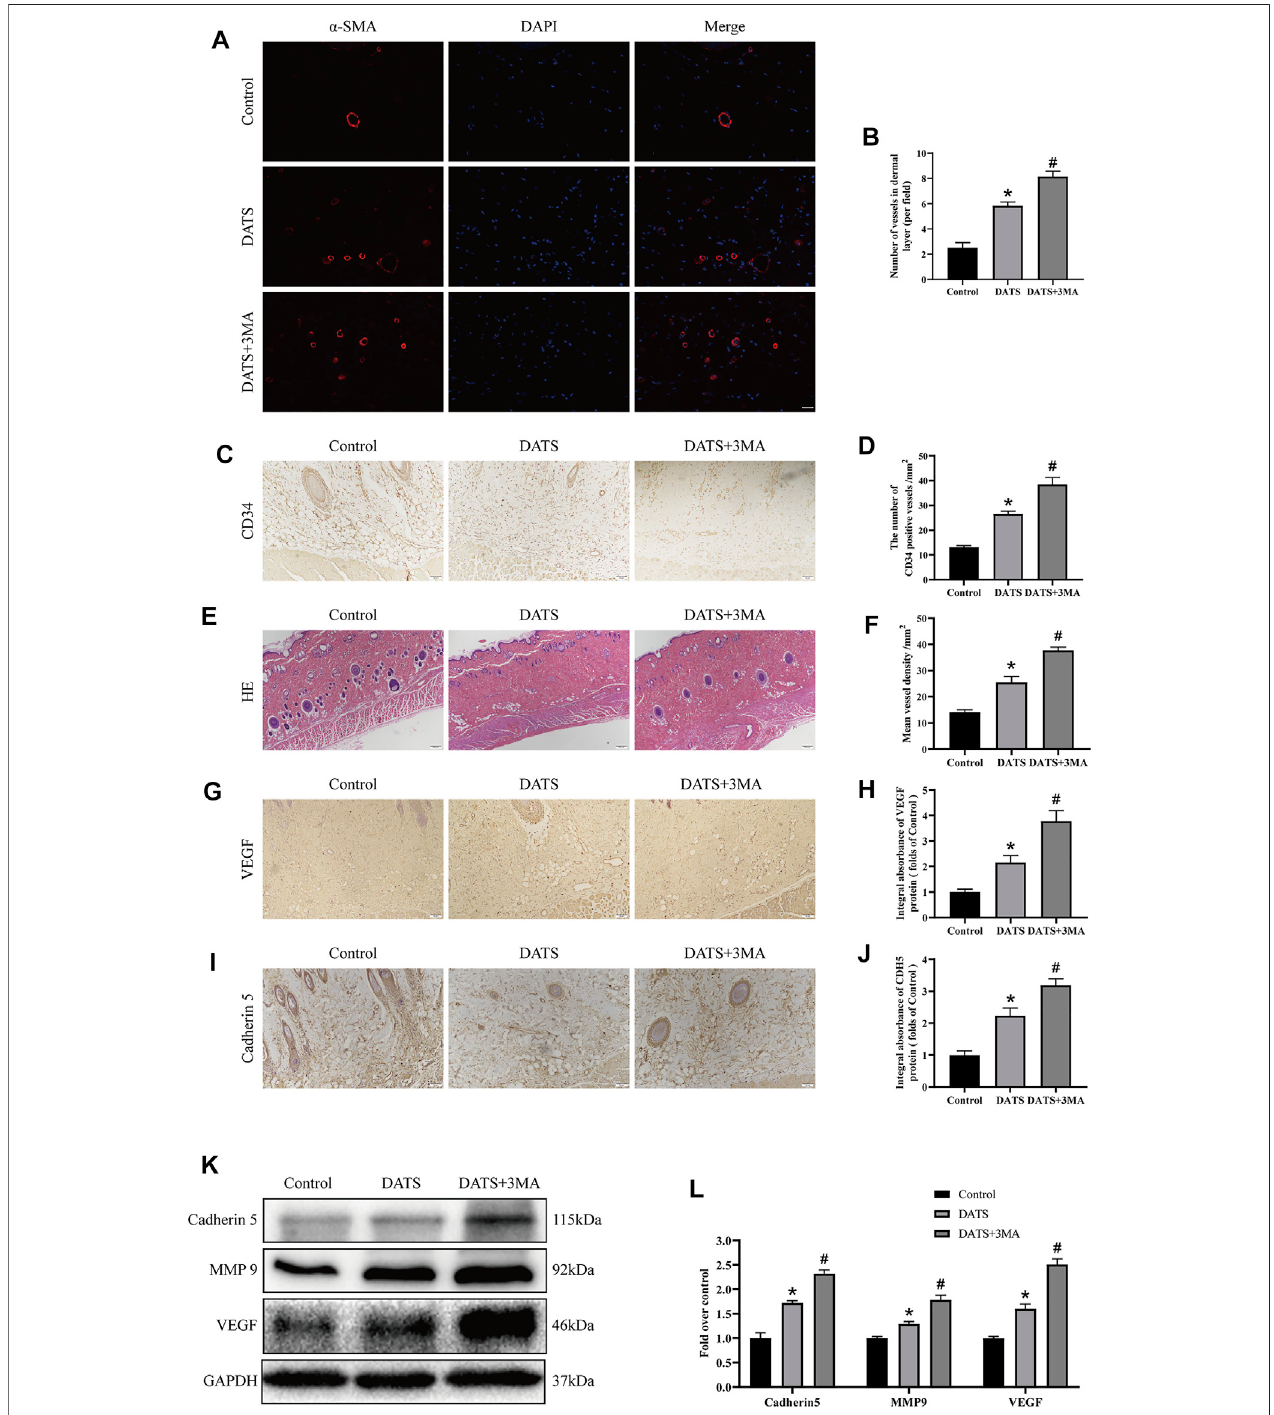
FIGURE 4 | DATS-induced autophagy affects angiogenesis in the multiterritory perforator fl ap. (A) α -SMA-positive microvessels in each group were evaluated by immuno fl uorescence(scalebar:50 µm). (B) Statisticalchartofthenumberof α -SMAmarkedmicrovesselsineachgroup. (C) IHCforCD34-positivemicrovesselsineach group (original magni fi cation ×200; scale bar, 50 µm). (D) The statistical chart describes the CD34-positive vessel density. (E) The H&E stainingshows themicrovessels and subcutaneous histology in each group (original magni fi cation ×100; scale bar, 100 μ m). (F) The statistical chart describes the percentage of microvascular density (MVD). (G,I) IHC forCadherin5and VEGFinthemultiterritoryperforator fl apineach group(original magni fi cation ×200; scalebar, 50 µm). (H, J) Statistical chart of the Cadherin 5and VEGF expression levels estimated byIHC. (K) Western blotting ofangiogenesis markers, Cadherin 5, VEGF, and MMP9 in thecontrol, DATS, and DATS+3MA groups. All the gel electrophoresis experiments were carried out under the same experimental conditions. (L) Statistical chart of the quanti fi cation of Cadherin 5, VEGF, and MMP9 expressions in the perforator fl aps. * p < 0.05, vs. control group; # p < 0.05, vs. DATS group. The obtained data were expressed as means ± SEM, n = 6 for every group. DATS, diallyl trisul fi de; IHC, immunohistochemistry.